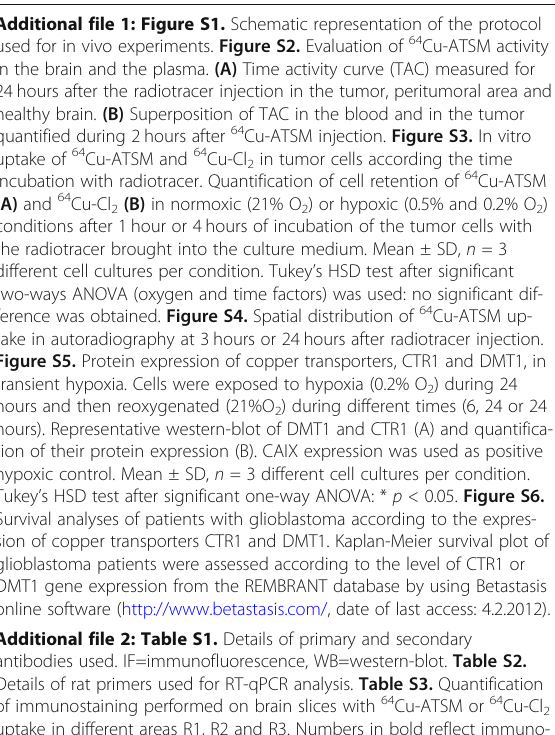
Additional file 2: Table S1. Details of primary and secondary antibodies used. IF=immunofluorescence, WB=western-blot. Table S2. Details of rat primers used for RT-qPCR analysis. Table S3. Quantification of immunostaining performed on brain slices with 64 Cu-ATSM or 64 Cu-Cl